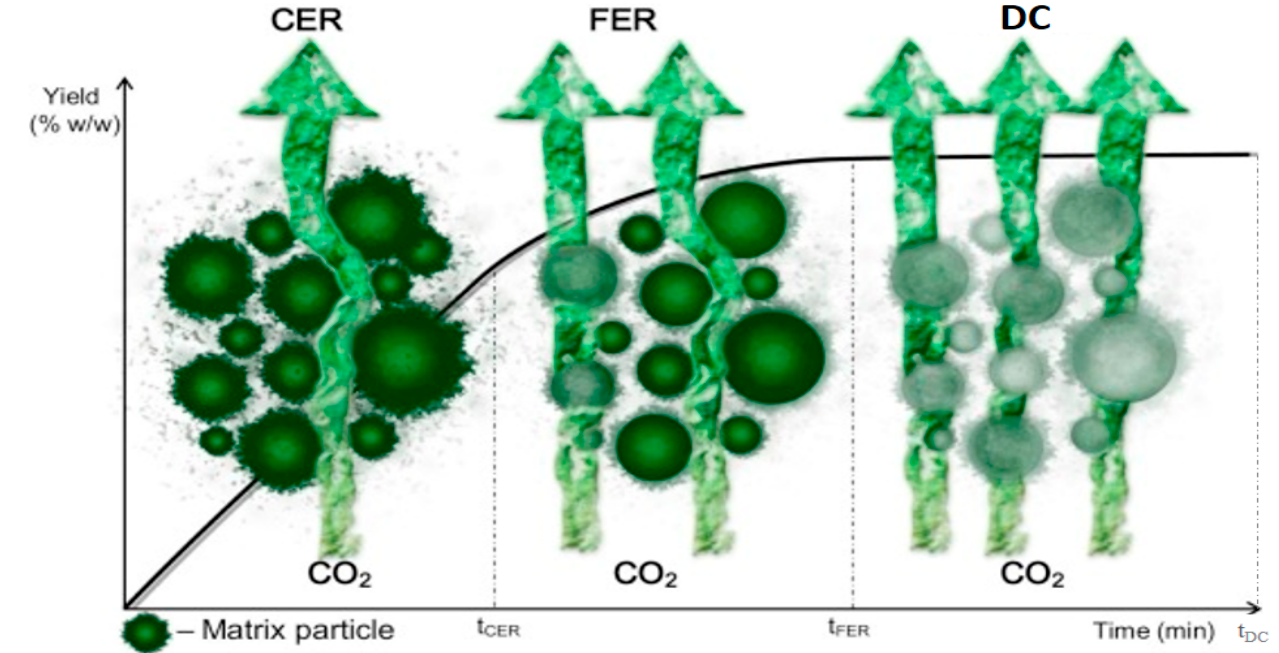
Figure 5. Graphical representation of mass transfer of bioactive compounds from cell membrane to solvent (modified and adopted with permission from Rui et al. [62]) .